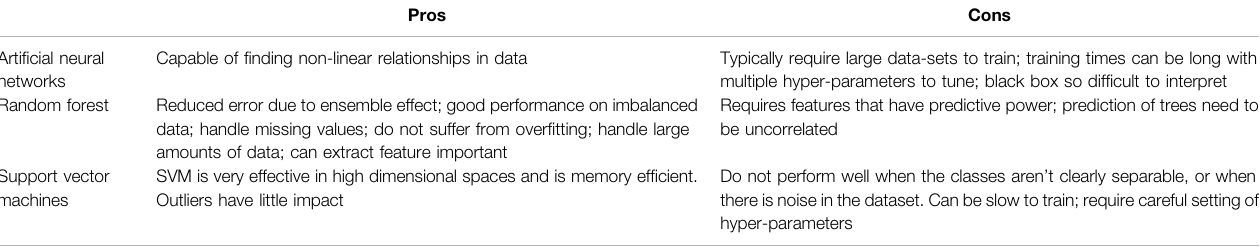
TABLE 1 | Summary of main pros and cons of each of the methods. Pros Cons